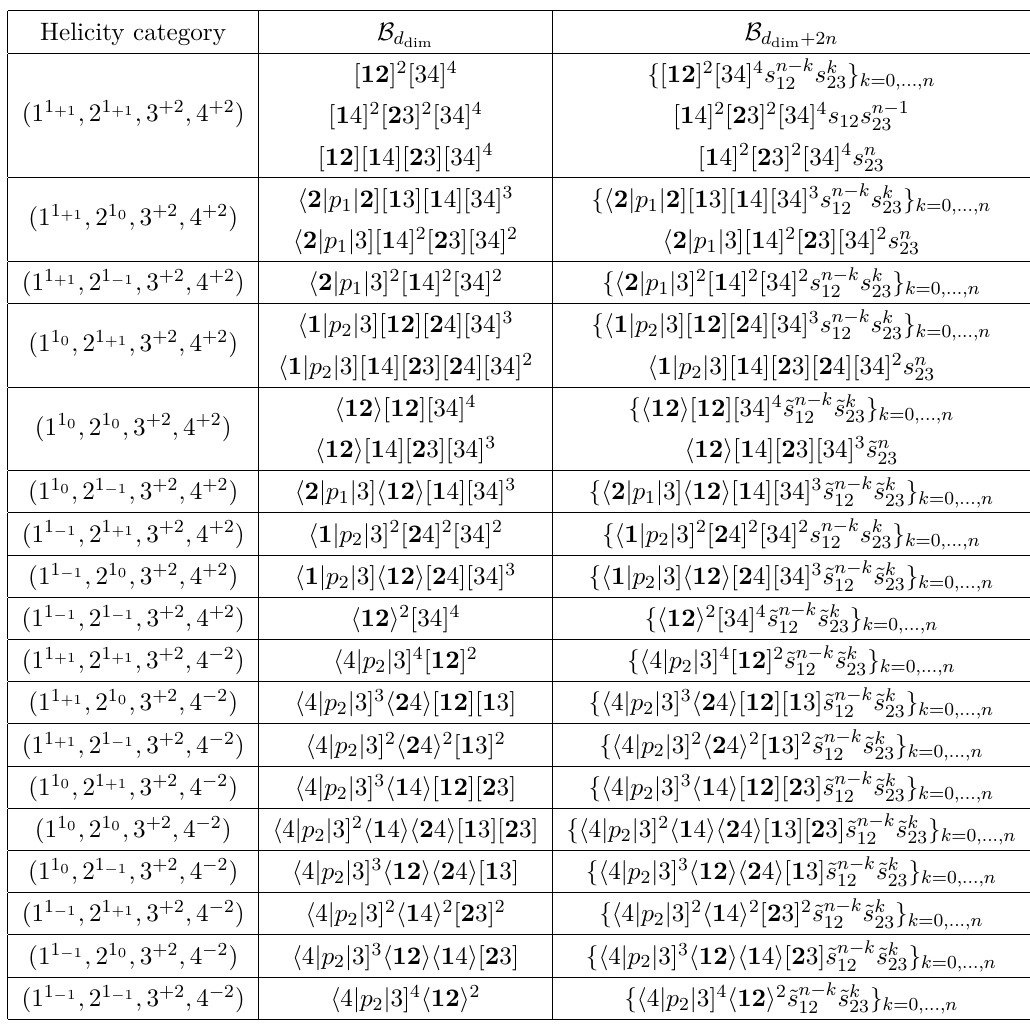
Table 1 . The helicity category bases for the spin-tidal interactions at S = 1